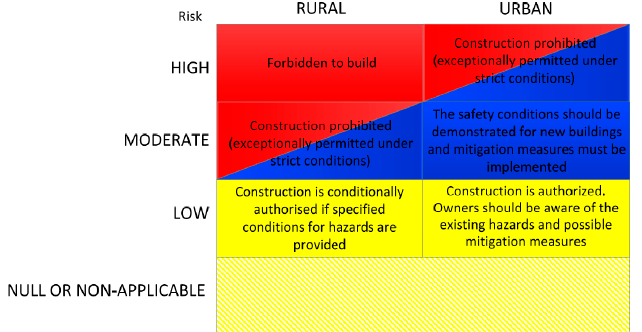
Figure 3. Land use transformation matrix.